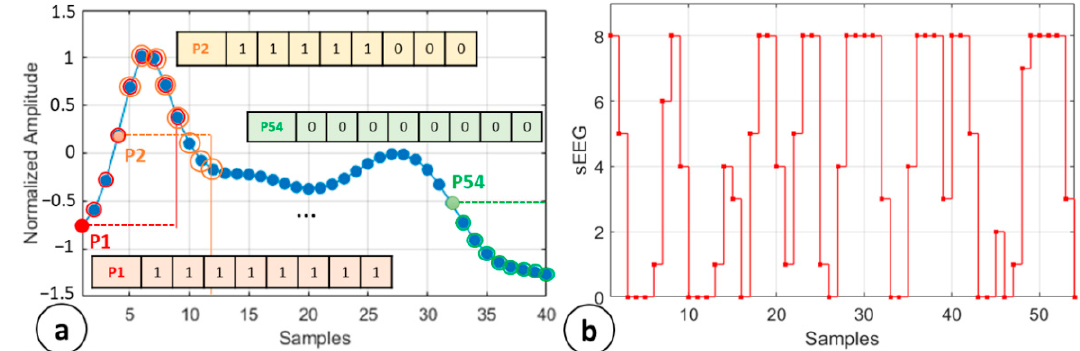
Figure 3. Implementation of 1D-LBP code. ( a ) 40-sample EEG data subset with LBP code extraction ( b ) sEEG from LBP routine application on a 168 samples trial.